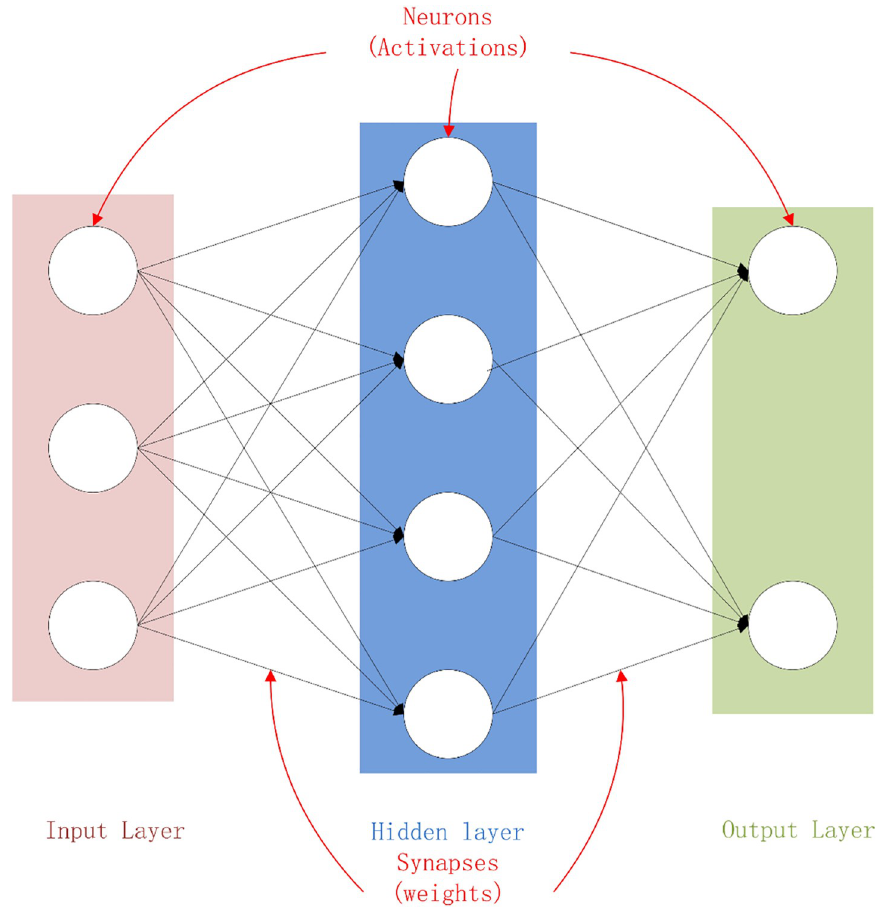
Fig 12. Diagram of the NN